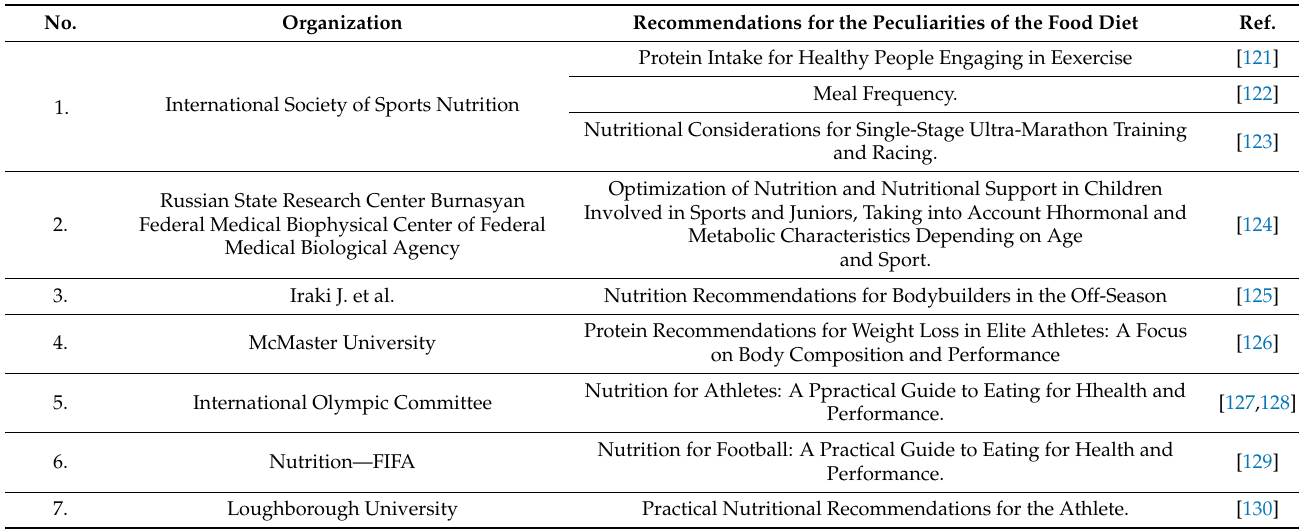
Table 2. Recommendations on the peculiarities of the nutritional diet by sports scientific and medical organizations and scientific